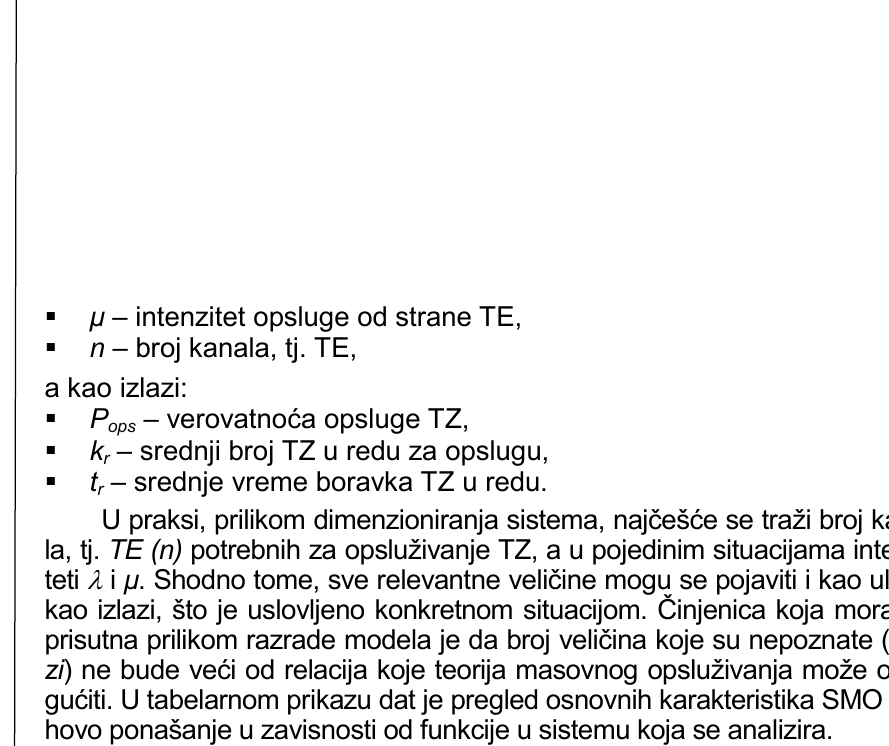
Tabela 1 Table 1